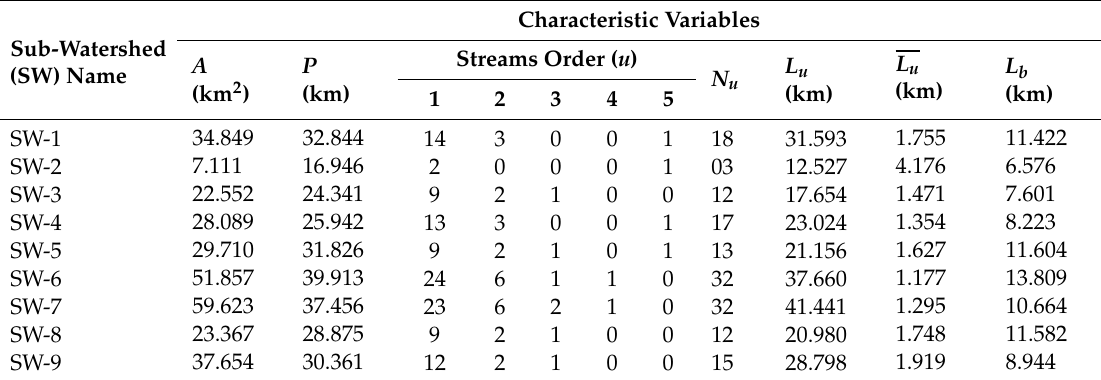
Table 4. Linear morphometric variables of nine sub-watersheds of BW.